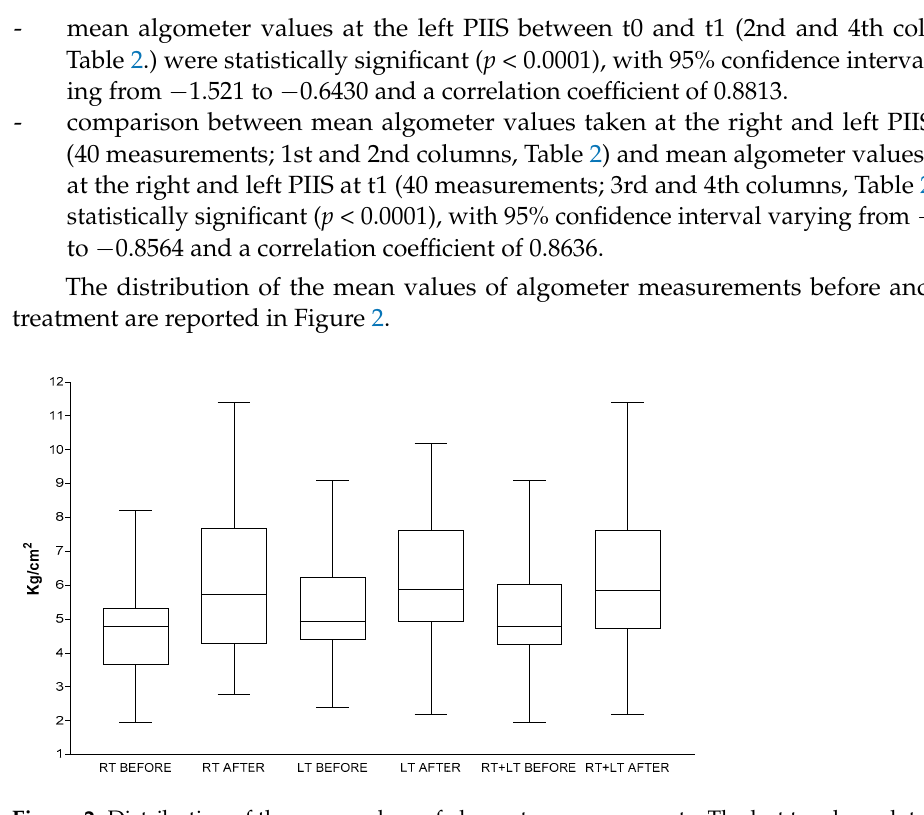
Figure 2. Distribution of the mean values of algometer measurements. The last two box-plots on the right represent the mean values of measurements taken at right and left PIIS before (t0) and after (t1) treatment. Abbreviations; RT = right; LT = left; RT + LT = right + left.